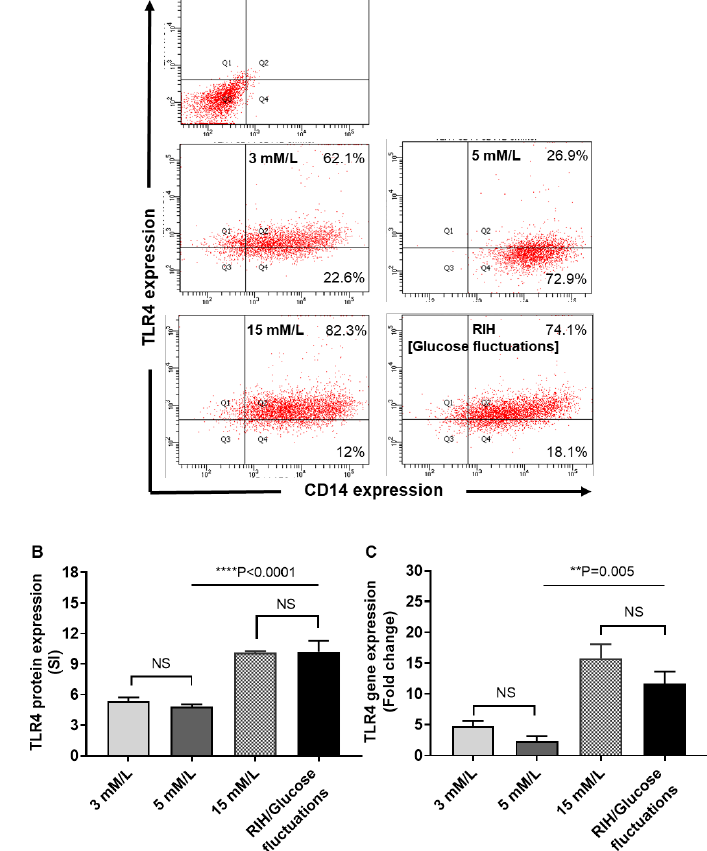
Figure 4. Repetitive intermittent hyperglycemia (RIH) promotes the expression of TLR4 on THP-1 macrophages. THP-1 transformed macrophages were cultured for 3 days under conditions of hypoglycemia (3 mM/L), normoglycemia (5 mM/L), persistent medium hyperglycemia (15 mM/L), and RIH/glucose fluctuations (3–15 mM/L). Cells were harvested and stained with fluorescent antibodies against CD14 and TLR4 along with isotype matched controls. TLR4 gene expression were measured using real-time qRT-PCR as described in the Materials and Methods section. ( A ) Representative flow cytometry data from three independent determinations with similar results are presented as dot blot for TLR4 vs. CD14 expression in macrophages. ( B ) Representative flow cytometry data from three independent determinations with similar results are presented as bar graph of mean staining index (SI). ( C ) Representative qRT-PCR data from three independent determinations with similar results are presented as bar graphs showing TLR4 gene expression as fold change over control gene expression taken as 1. All data are expressed as mean ± SEM values. ** P ≤ 0.01, **** P ≤ 0.0001, and NS: nonsignificant. 3.6. RIH Induces the Expression of Matrix Metalloproteinase (MMP)-9, Enhancing the Risk for Diabetes- Related Pathologies in a Clinical Setting